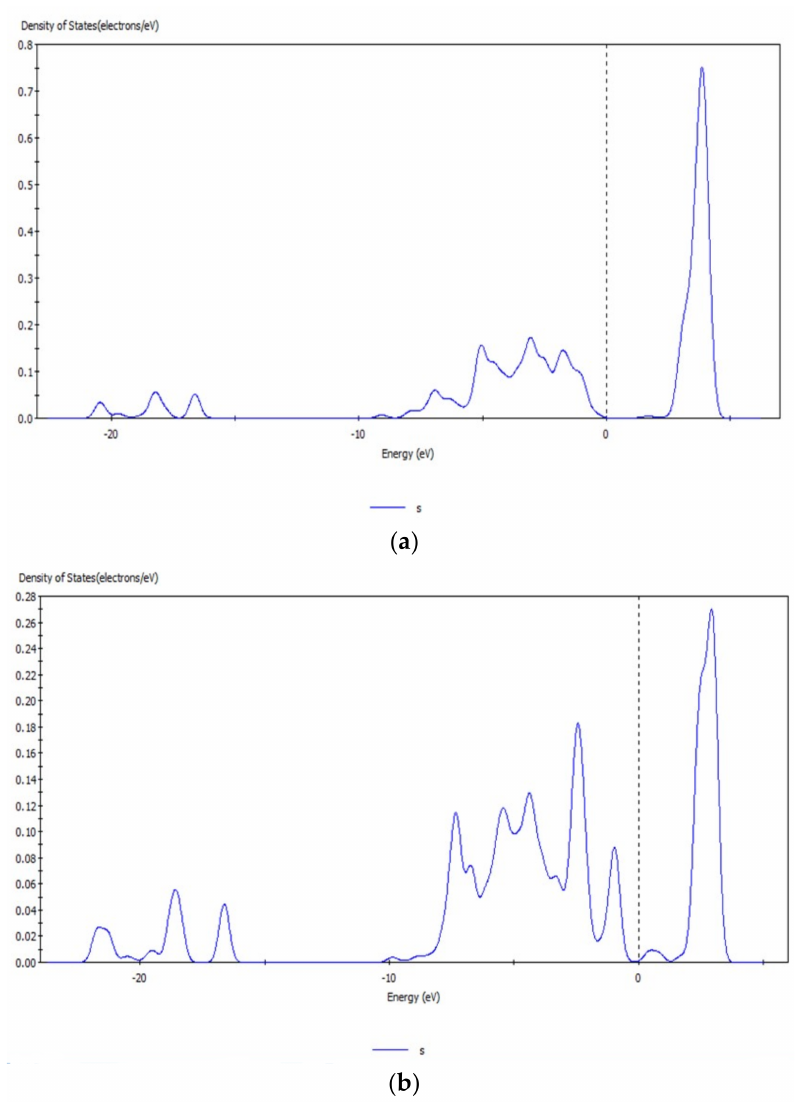
Figure 9. s orbital before ( a ) and after ( b ) transformation of CO 3 2 − with